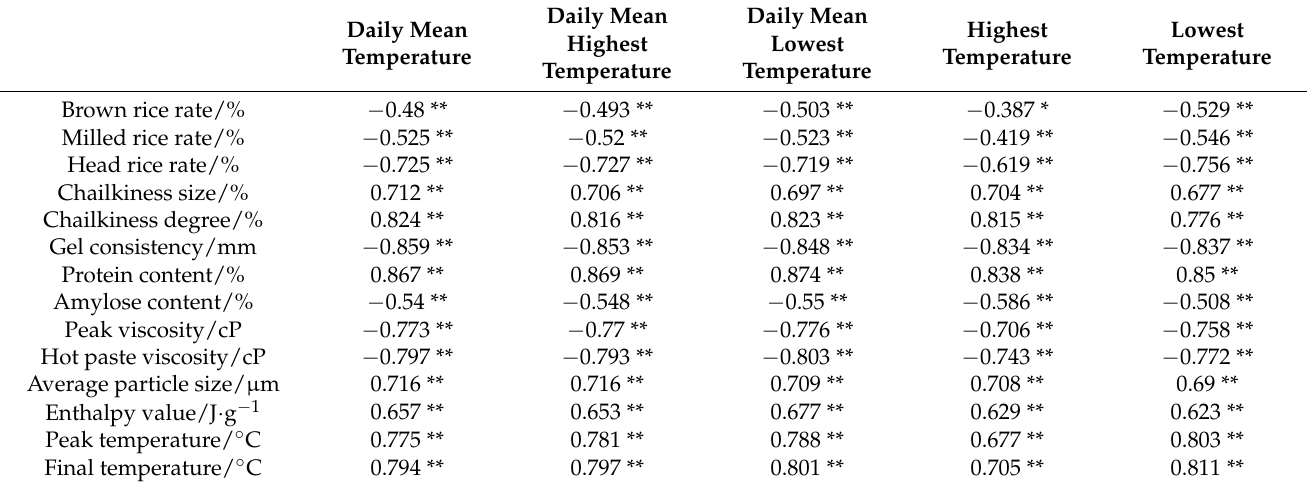
Table 9. Correlation analysis between temperature and